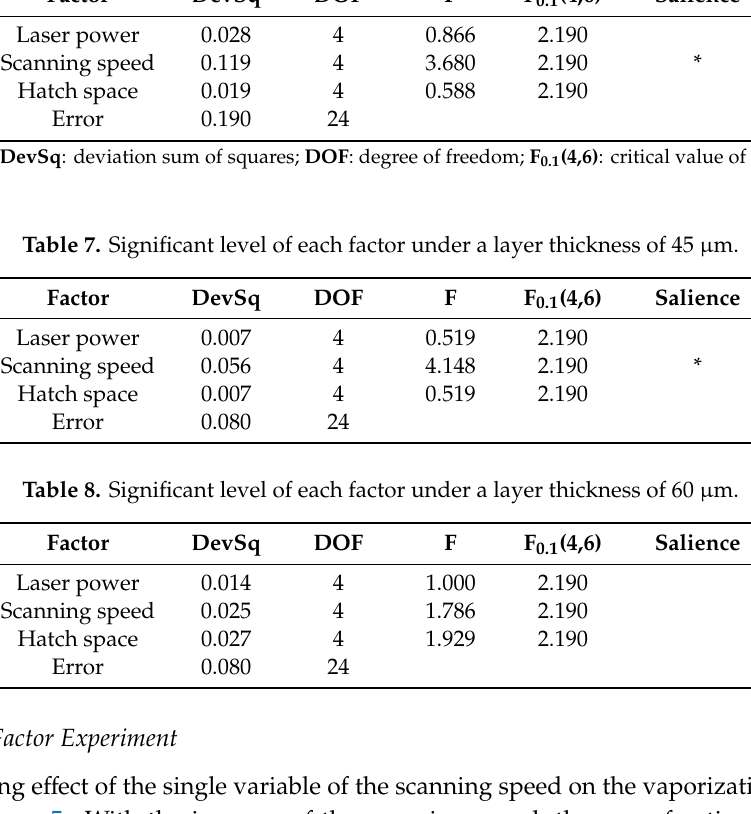
Table 6. Significant level of each factor under a layer thickness of 30 µ m.